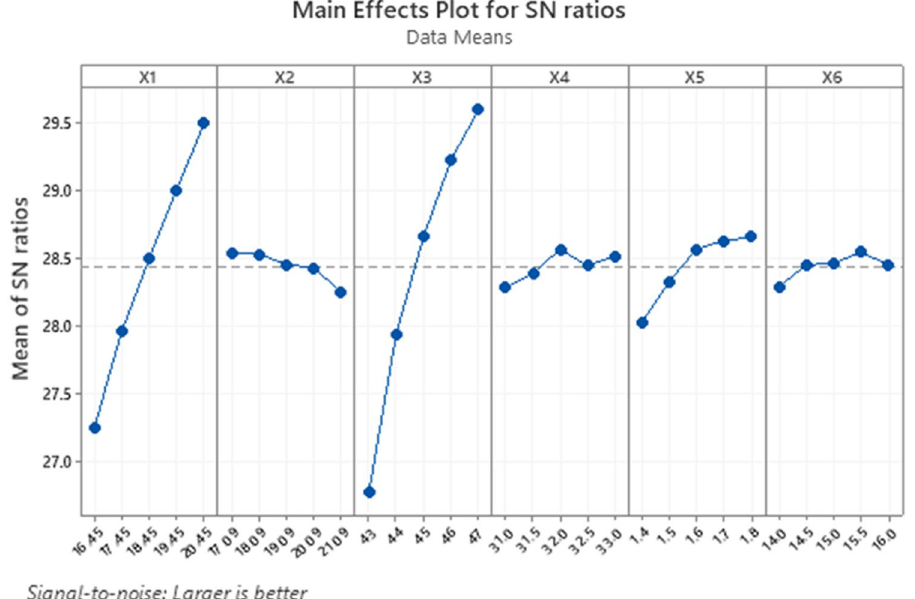
Fig. 8 Main effects plot for S / N ratio (St), smaller is better